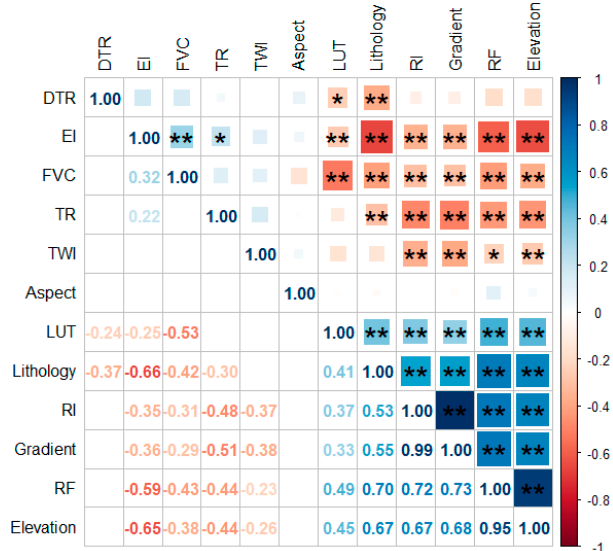
Figure 4. Correlation analysis chart of susceptibility indicators.